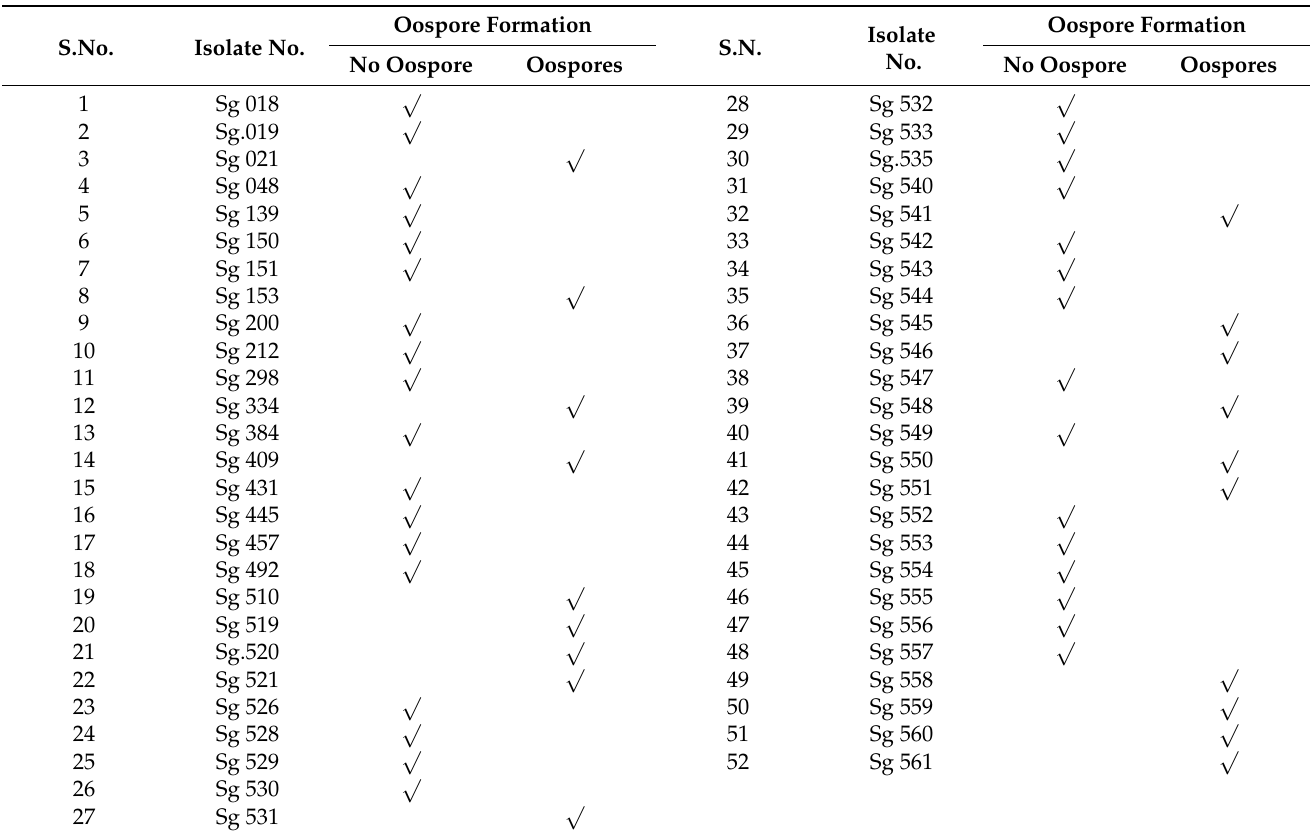
Table 2. Observation on oospore formation in 52 selfed Sclerospora graminicola isolates.